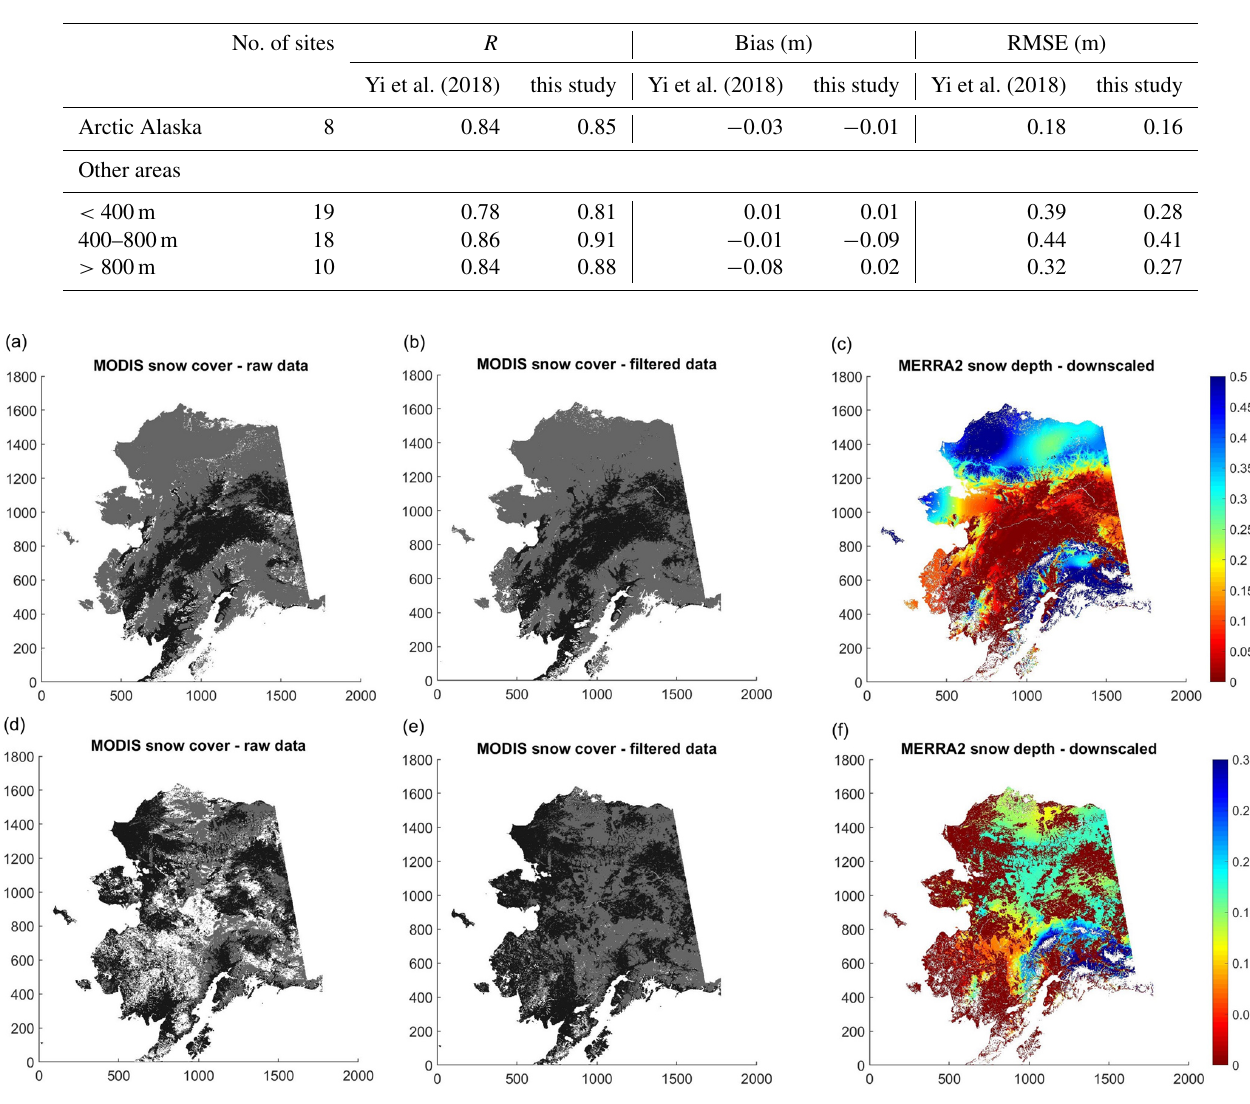
Table 3. Statistics of 1km MERRA-2 snow depth data generated using different spatial interpolation schemes compared with in situ snow depth measurements at the Alaskan SNOTEL sites.